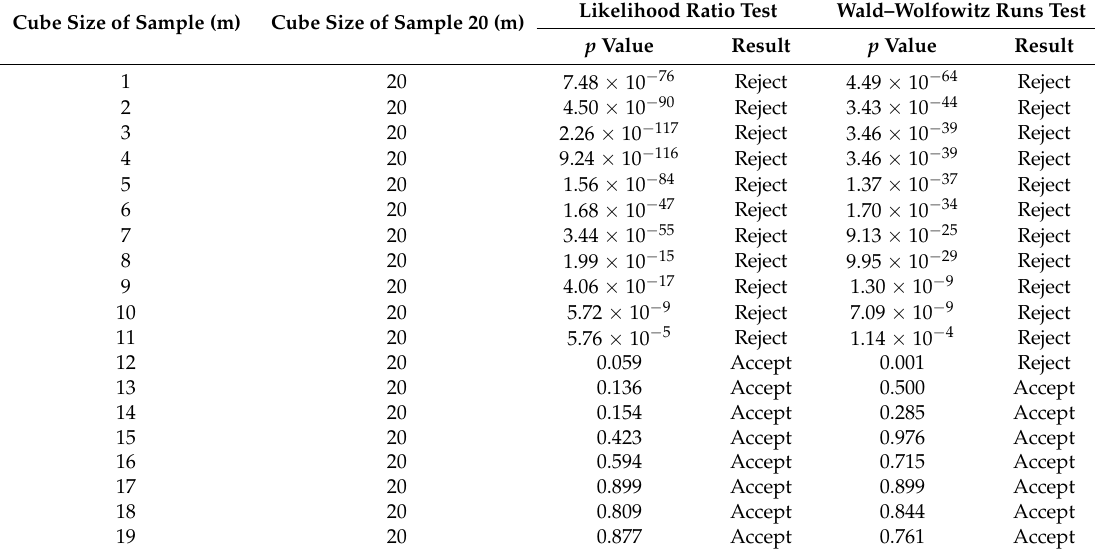
Table 4. Results of the likelihood ratio test and Wald–Wolfowitz runs